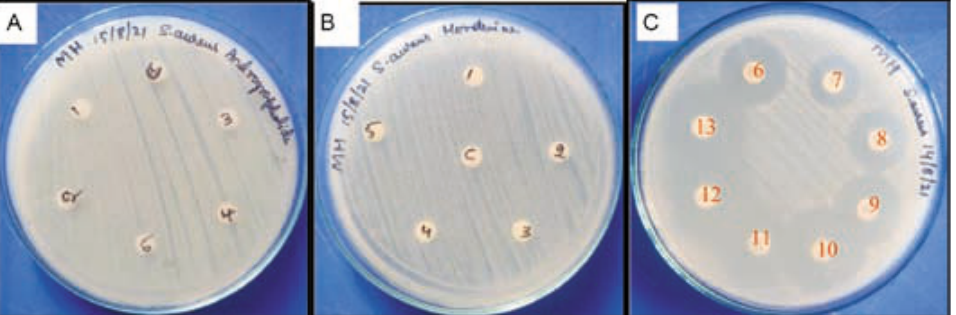
Fig. 2. In vitro antibacterial activity of (A) andrographolide and (B) hordenine (C) antibiotics against S. aureus : C- control, 1-1000 µg/mL, 2- 500 µg/mL, 3- 250 µg/mL, 4- 125 µg/mL, 5- 62.5 µg/mL, 6- Doxycycline,